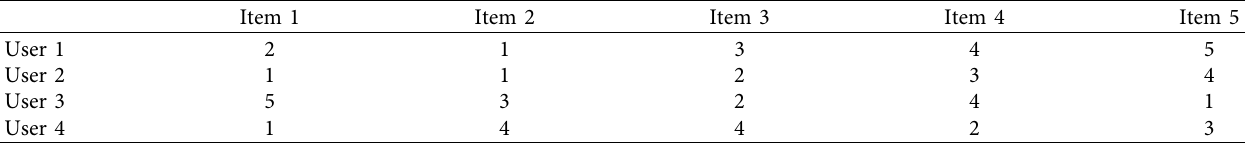
Table 2: Example of user rating matrix.